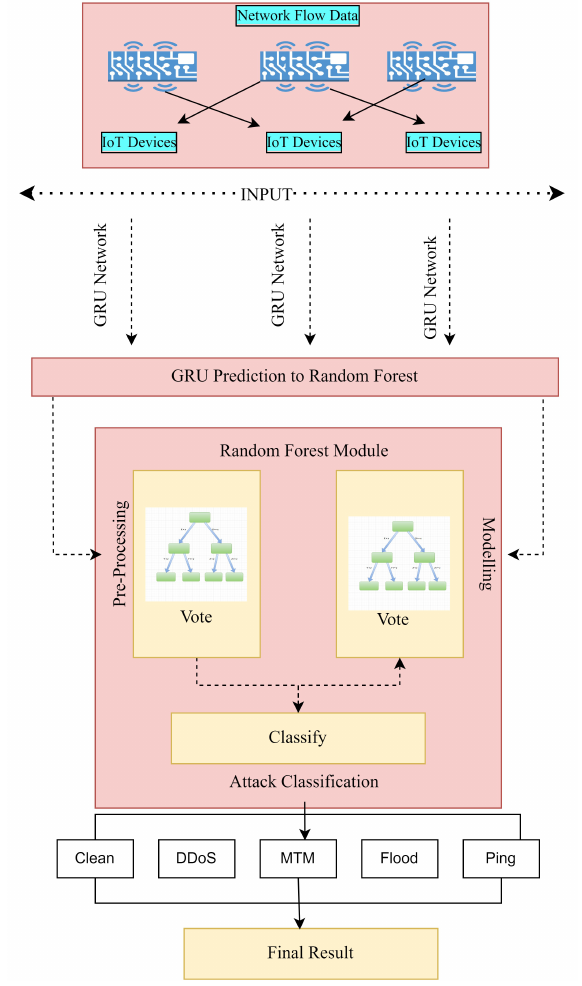
Figure 3. Illustration for Attack